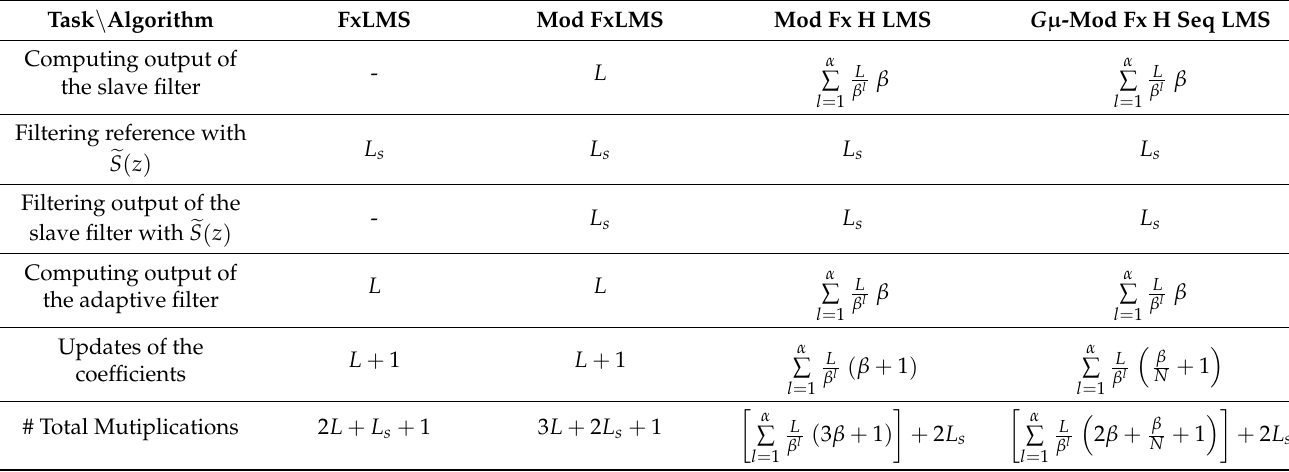
Figure 8. Compared performance of FxLMS algorithm, Mod FxLMS algorithm and G µ —Mod Fx H Seq LMS, ( a ) N = G µ = 1 and ( b ) N = G µ = 4. Table 1. Comparison of computational complexities of active noise control (ANC) algorithms, in terms of the average number of multiplications per task and iteration, in a single channel implementation of an ANC system. Task \